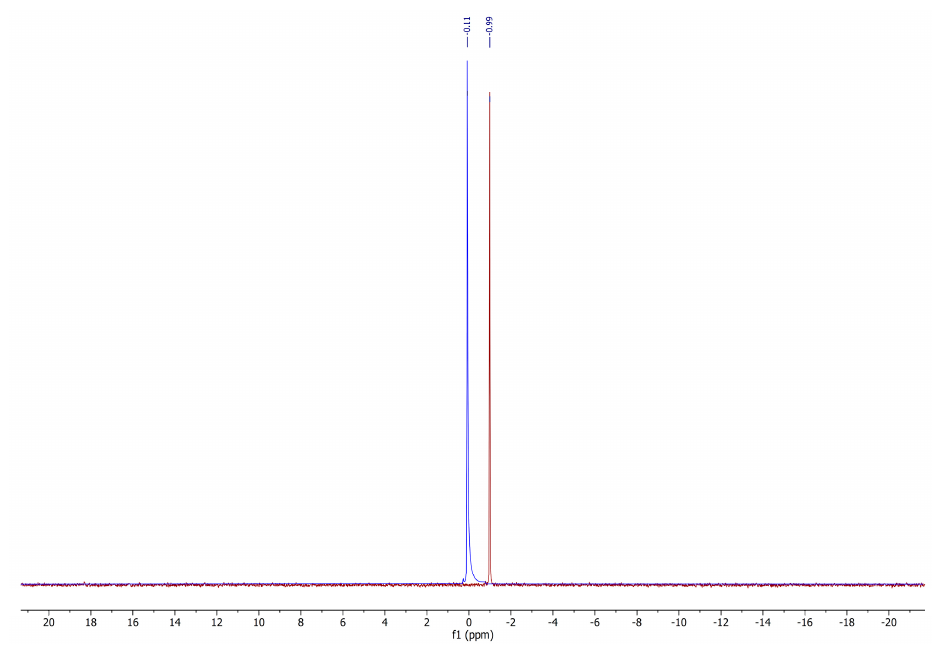
Figure 2. 31 P NMR spectra of H 3 PO 4 and phosphorylated lignin in DMSO- d 6 .